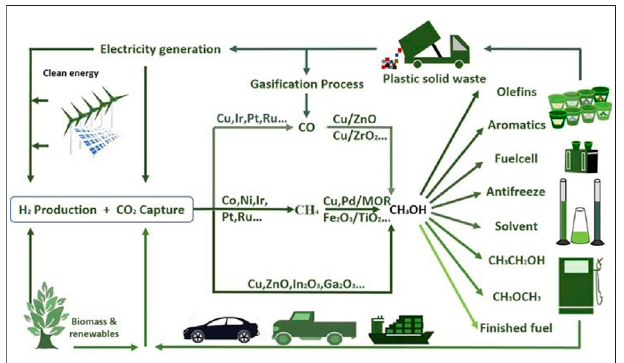
FIGURE 5 | The simpli fi ed carbon cycle with methanol as platform molecule in the